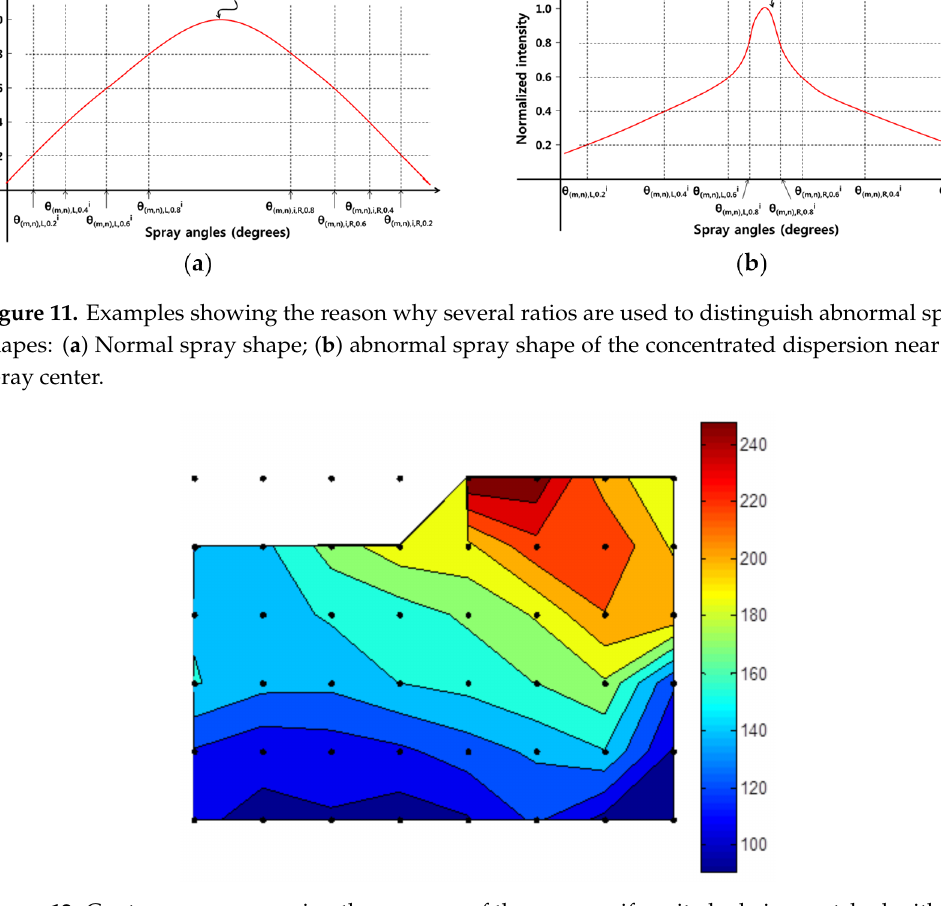
Figure 12. Contour map experssing the measure of the spray uniformity by being matched with the array of images in Figure